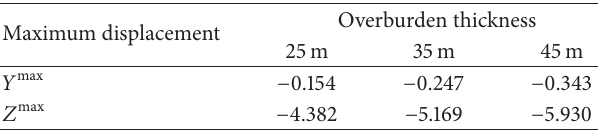
Table 5: Maximum displacements of tunnel structure under differ- ent overburden